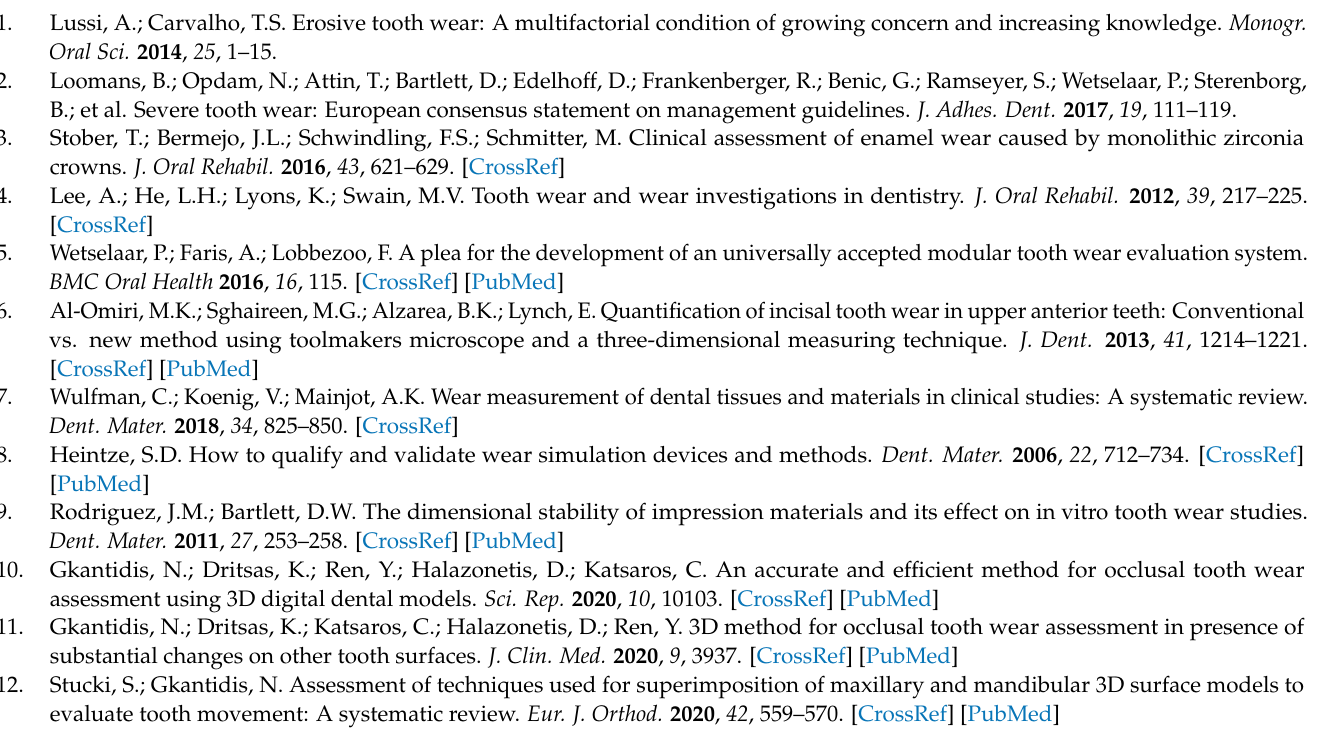
standard technique. Figure S2: Intra-operator error of tooth wear volume measurement shown in Bland Altman plots. Figure S3: Difference in tooth wear measurement between the technique of choice (complete crown, setting D) and the gold standard technique by tooth type and wear amount. Figure S4: Superimposition of identical surface models of a maxillary molar and a maxillary